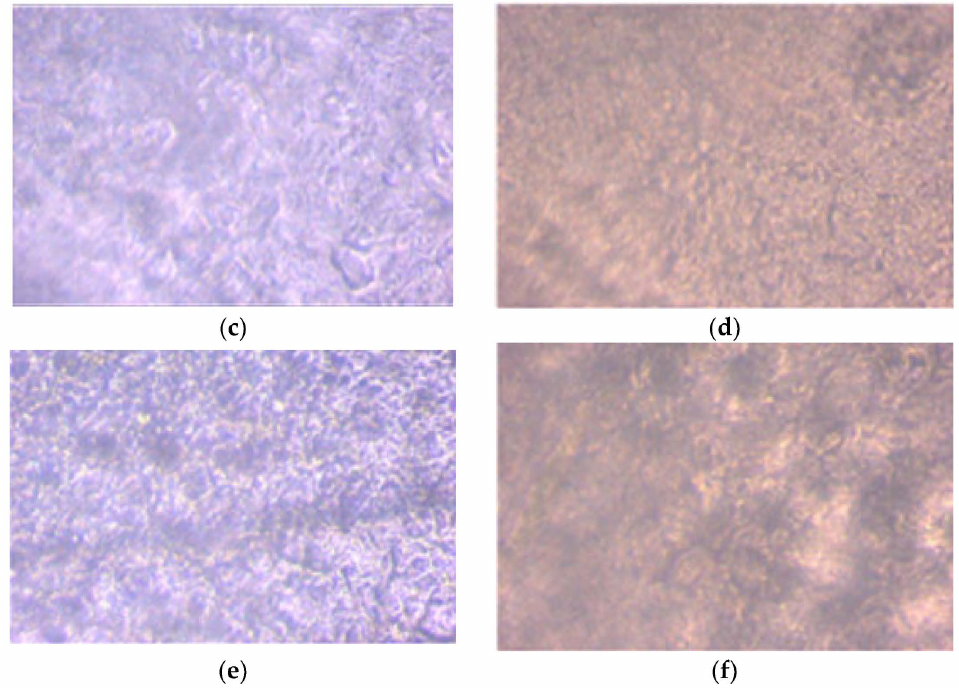
Figure 1. Optical micrographs of the films surface at 40 × of films: ( a ) F1, ( b ) F2, ( c ) F3, ( d ) F4, ( e ) F5 and ( f ) F6.